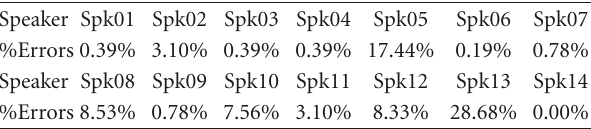
Table 2: Rate of vowel mispronunciations per speaker.